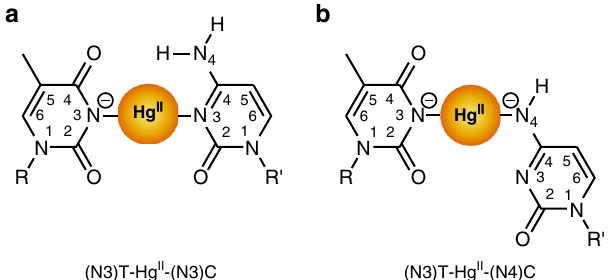
Fig. 1 Proposed C-Hg II -T binding modes. a , (N3)T-Hg II -(N3)C coordination based on structural homology with T-Hg II -T 32 and b , (N3)T-Hg II -(N4)C